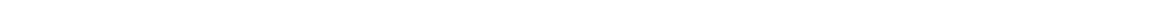
Fig. 6 Second generation TEAD binder has favorable stability. a Reversed-phase (RP) HPLC trace of TB1G2 under non-reducing or strongly reducing (10 mM DTT) conditions (top). The sample under reducing conditions was analyzed in an in-line LC/MS mass spectrometer, identifying peaks of interest (middle). Peptide m/z of representative peak P1 (bottom) shown, corresponding to a mass of 4971.4 Da. The non-reduced peptide ’ s mass was measured at 4968.7 Da on the same instrument. Full mass spectra available in Supplementary Fig. 10. b RP-HPLC of TB1G1 and TB1G2 under either non-reducing (NR) or intracellular reducing conditions using 10 mM glutathione (GSH). c 293F cells expressing SDGF-TB1G1 (top) or SDGF-TB1G2 (bottom) were incubated with either PBS, 10 mM glutathione (GSH) or 10 mM DTT for 5 mins before being washed and tested for TEAD binding (20 nM, 2-step stain with Alexa Fluor 647-streptavidin). d A control peptide, with known sensitivity to proteases, was cloned into SDPR and incubated with PBS or either 40 µ g mL − 1 trypsin (top left) or 40 µ g mL − 1 chymotrypsin (top right), followed by treatment with reducing agent (5 mM DTT) and iFluor 647 anti-6xHis staining. Bottom: Same as top, with cells expressing SDPR-TB1G2. e , f Circular dichroism spectra of soluble CDPs TB1G2 e and TB1G2-W40P f indicate a structure dominated by α -helical elements, and that this secondary structure signature is identical before (Pre) and after (Post) incubation at 95 °C. Insets: relative ellipticity at 220 nm during heating from 20 °C to 95 °C. g SYPRO Orange thermal shift assay of optides. Shown is the slope of the change in relative